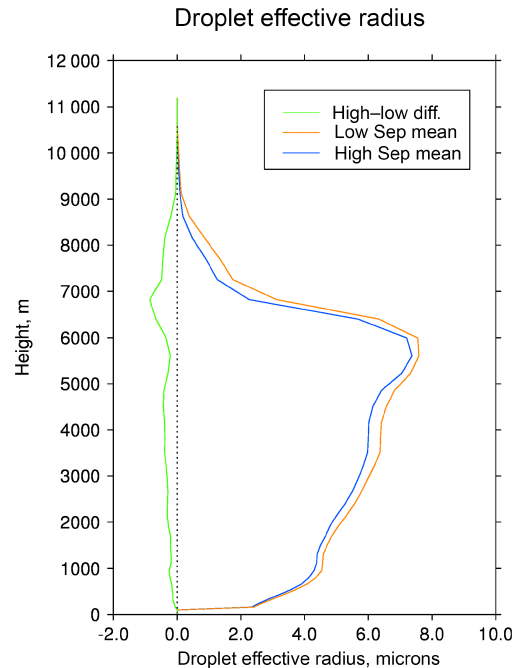
Figure 9. Vertical profile of September mean differences of droplet effective radius (microns) (averaged over the BB box 5–25 ◦ S, 40– 70 ◦